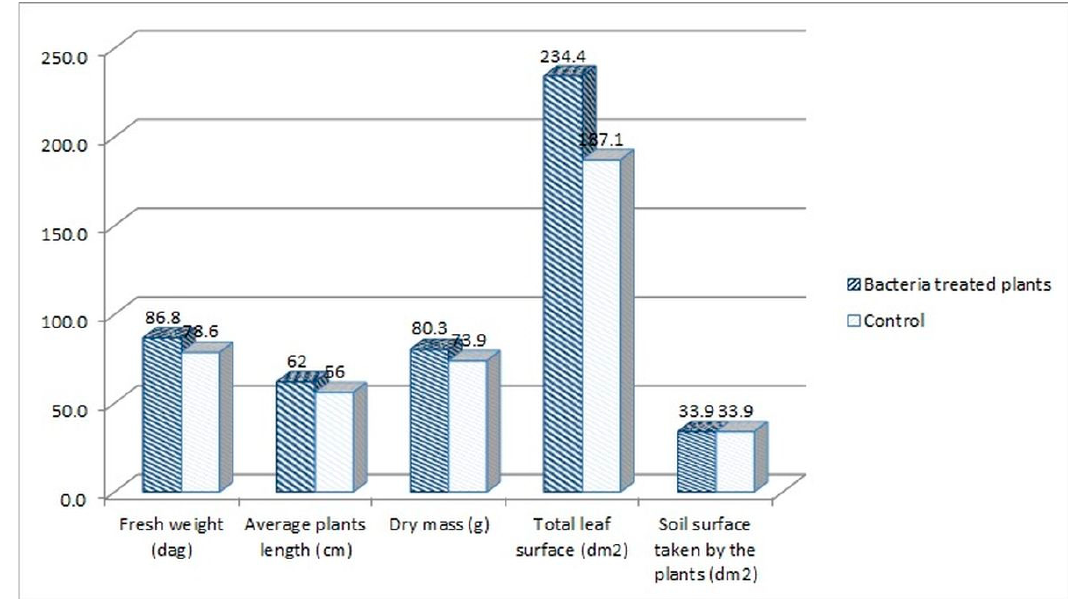
Figure 4. The parameters measured for the consortium-treated tomato plants in comparison to the control group, tomato plants treated only with water.